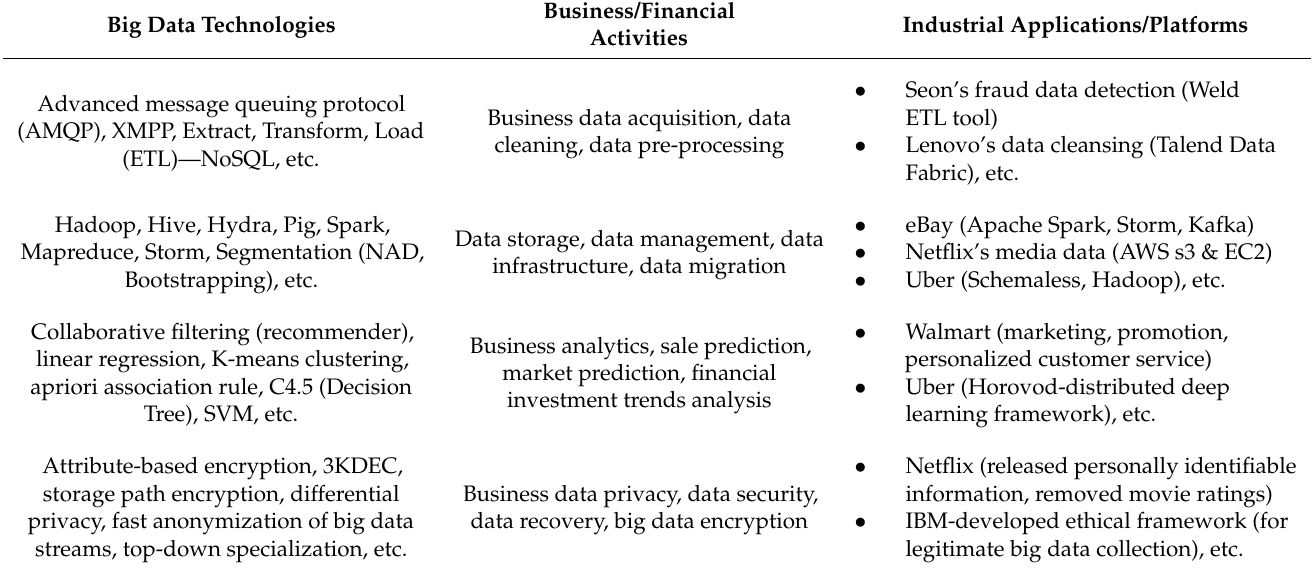
Table 1. Big data technologies applied in the business and financial sectors